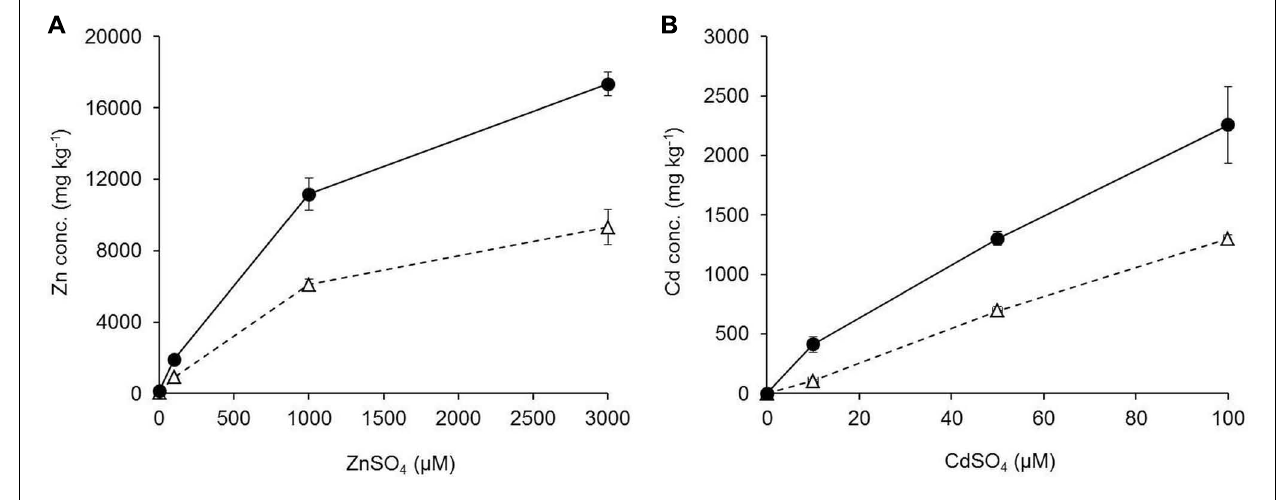
FIGURE 5 | Zinc (Zn) (A) and cadmium (Cd) concentrations (B) (in mg kg –1 dry weight; mean ± SE) of G. claussenii shoots ( (cid:2) ) and roots ( • ) upon growth in hydroponic nutrient solutions. Plants were grown for 3